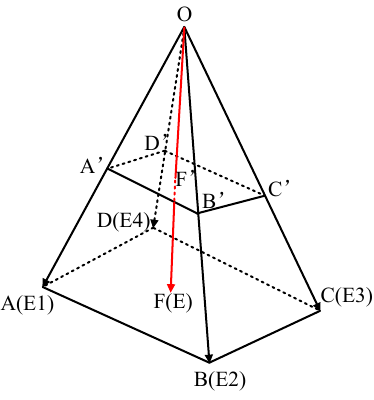
Figure 8. Camera projection model.